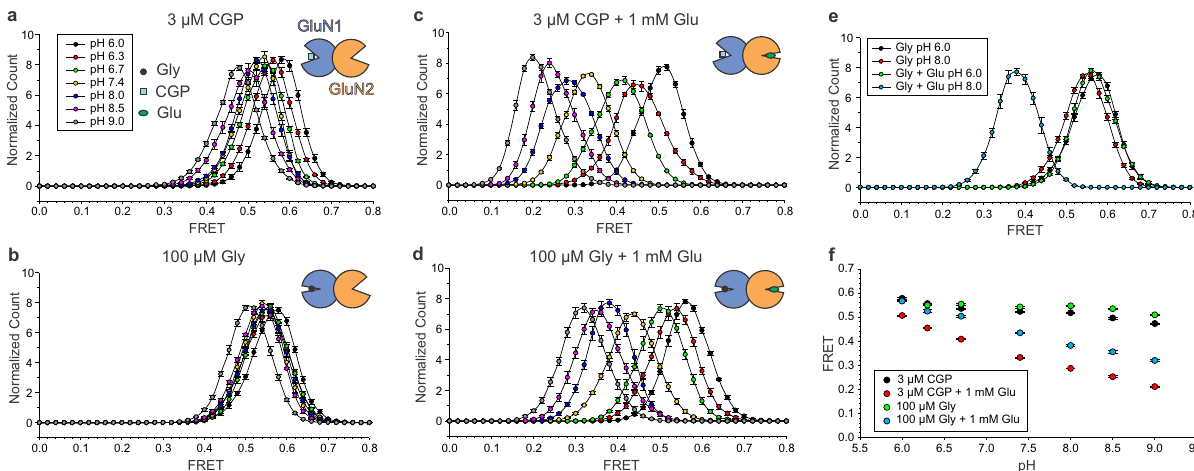
Fig. 5 pH selectively modulates glutamate-induced dimer separation. a – d Effect of pH on the smFRET histogram of the SNAP_GluN1-1a/GluN2B receptor in 3 µ M CGP ( n = 5 movies for pH 6.0, 6.3, 6.7, 8.0, and 8.5, n = 4 movies for pH 7.4, 9.0, SEM error bars) ( a ), 3 µ M CGP + 1 mM glutamate ( n = 5 movies for pH 6.0, 6.7, 7.4, 8.5, and 9.0, n = 4 movies for pH 6.3, 8.0, SEM error bars) ( c ), 100 µ M glycine ( n = 5 movies for each pH condition, SEM error bars) ( b ), and 100 µ M glycine + 1 mM glutamate ( n = 5 movies for pH 6.3, 7.4, and 8.5, n = 4 movies for pH 6.0, 6.7, 8.0, and 9.0, SEM error bars) ( d ). e Little difference in smFRET histograms between pH 6.0 and 8.0 in 100 µ M glycine (both histograms n = 5 movies, SEM error bars), but large difference in 100 µ M glycine + 1 mM glutamate (both pH 6.0 and 8.0 histograms n = 4 movies, SEM error bars). pH 6.0 brings receptor fully occupied by glycine and glutamate (100 µ M glycine + 1 mM glutamate) into a state indistinguishable from the resting Apo state at pH 8.0 (here represented by glycine-bound state). f Mean maximum FRET histogram values in various ligand combinations across